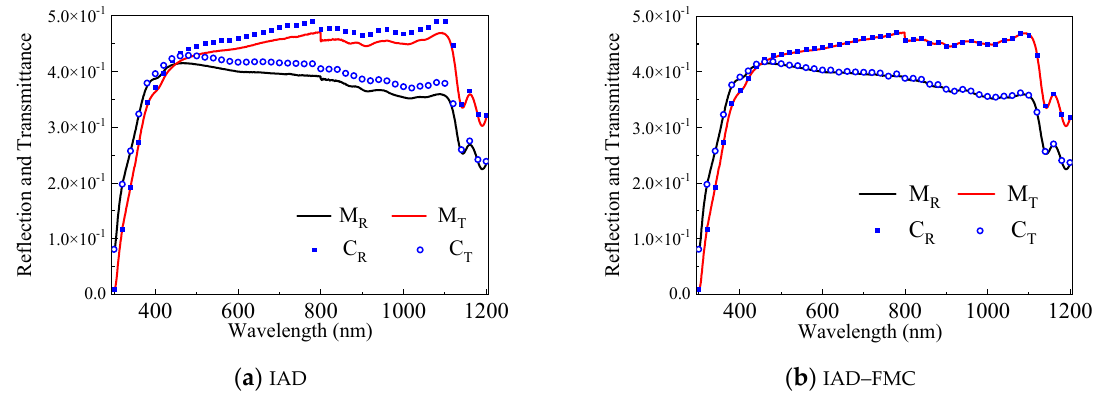
Figure 9. Measured and calculated reflection and transmittance.